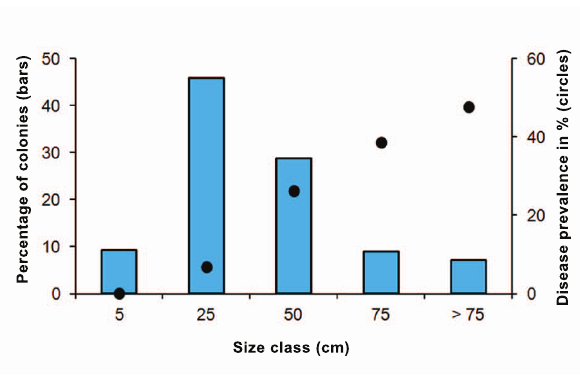
Figure 2. Size frequency distribution (blue bars) of Acropora palmata colonies at Limones reef, Mexico in 2012 (n=292